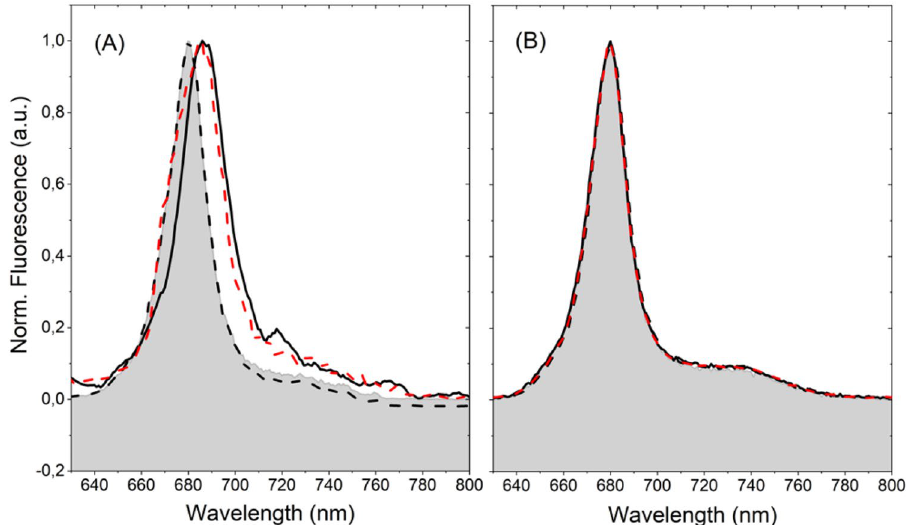
Figure 5. Emission spectra of ensembles of SCP complexes ( A ) embedded in PVA for excitation intensities of 525 W/cm 2 , and ( B ) dissolved in bulk buffer solution at a concentration of 1.45 × 10 –7 M, and excitation intensities of 30 µW/cm 2 . Key: Dashed black lines—emission spectra for protocol 3; dashed red